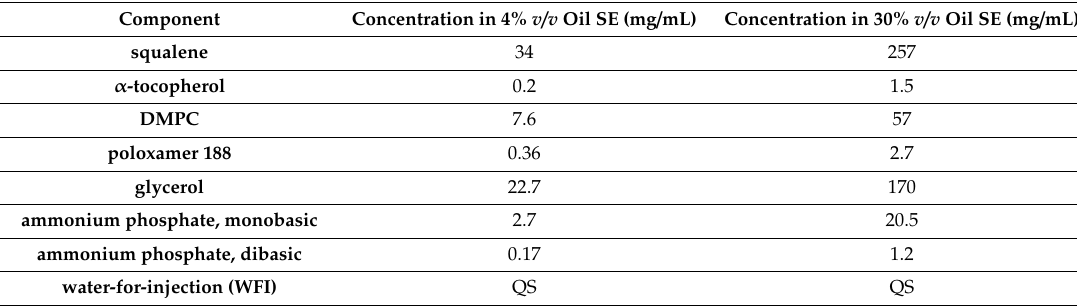
Table 1. Squalene emulsion (SE)